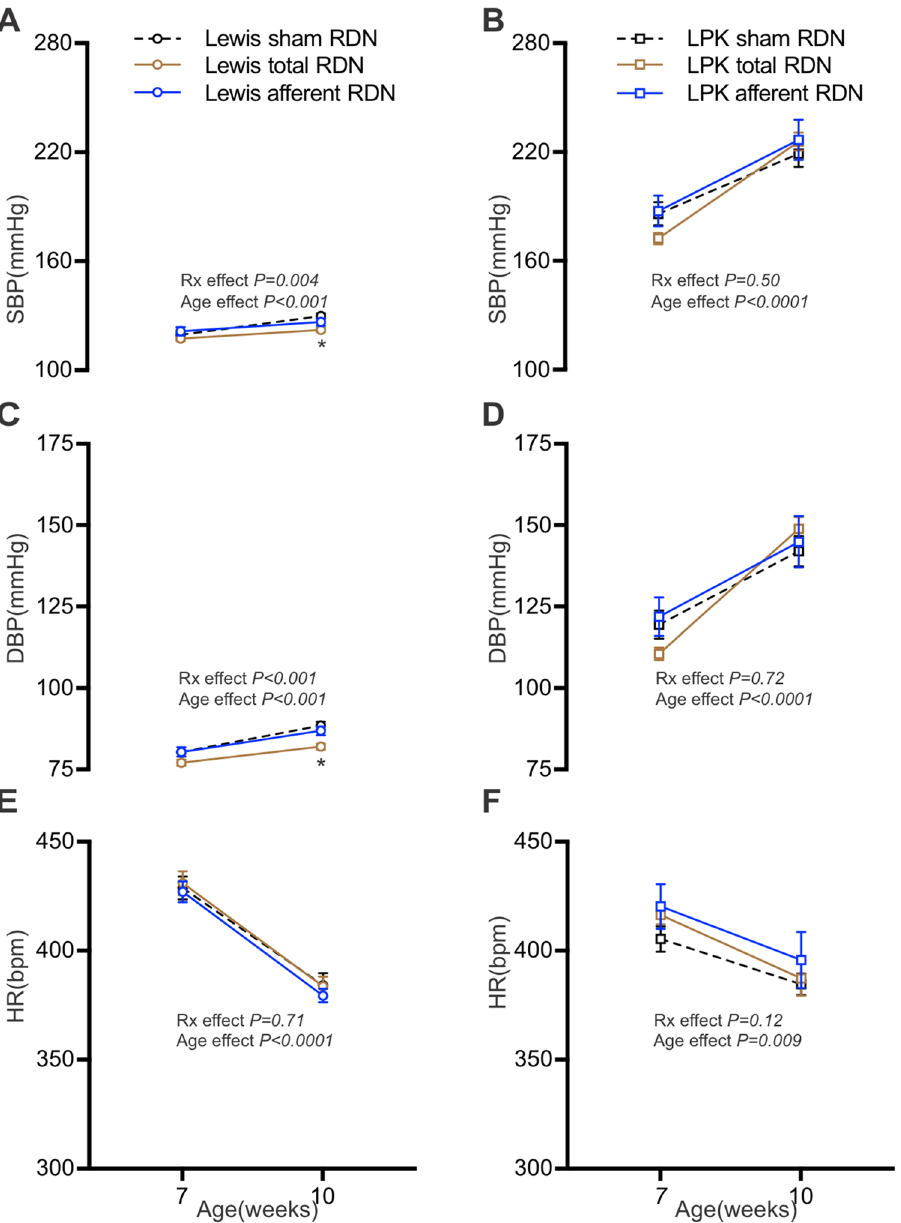
Figure 2. The effect of RDN on systolic blood pressure (SBP; A , B ), diastolic blood pressure (DBP; C , D ) and heart rate (HR; E , F ) in Lewis ( A , C and E ) and LPK ( B , D and F ) rats at 7 and 10 weeks of age after sham, total and afferent RDN procedures. Rx, treatment effect. Data is expressed as mean ± SEM. *indicates P < 0.05 difference between sham and total RDN groups at 10 weeks old, analysed using two-way ANOVA and Bonferroni’s post hoc analysis. Overall age and treatment effects are provided in each panel. N values at 7 and 10 weeks for Lewis sham = (10, 11); Lewis total = (14, 13); Lewis afferent = (9, 10) respectively and for LPK sham = (13, 11), LPK total = (14, 12) and LPK afferent = (9, 8),